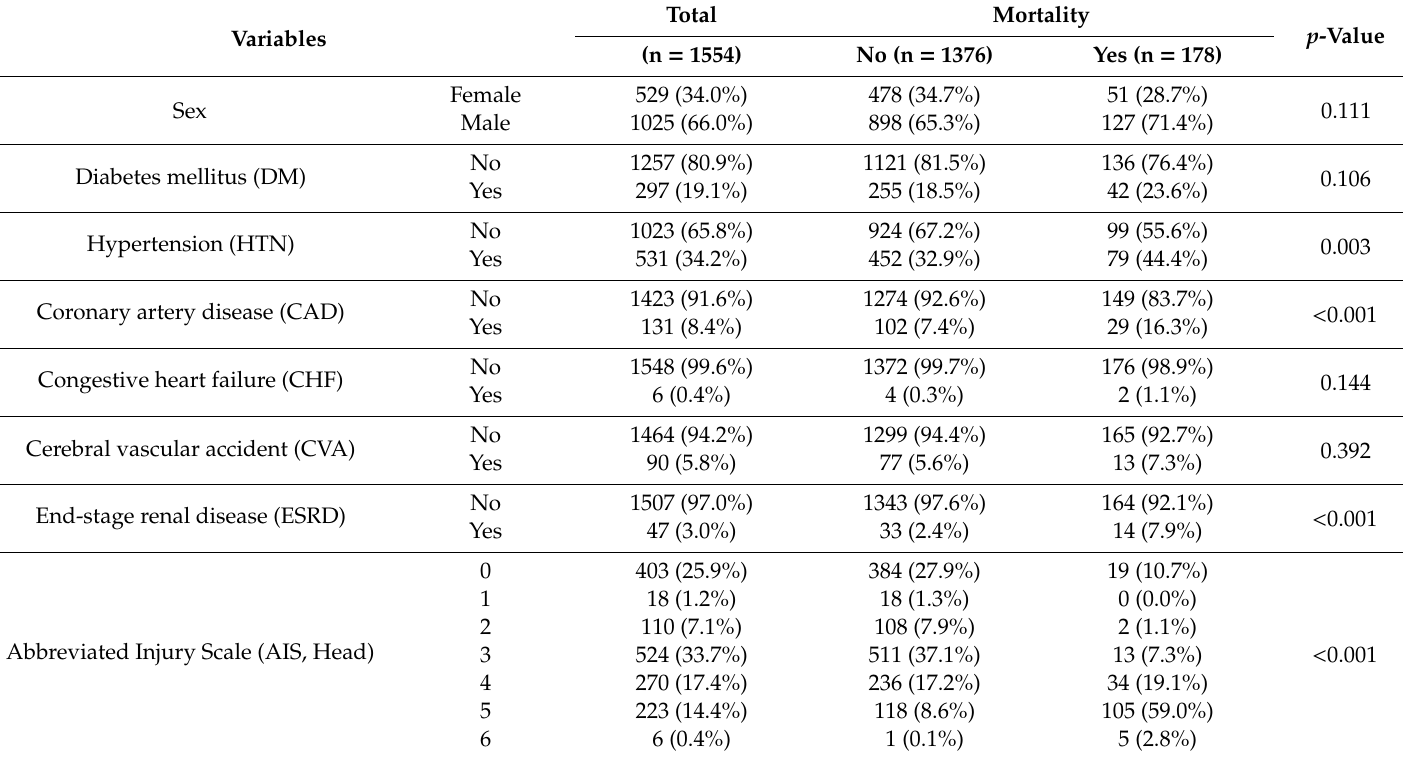
Table 1. Categorical variables of characteristics of critically ill trauma patients who died or